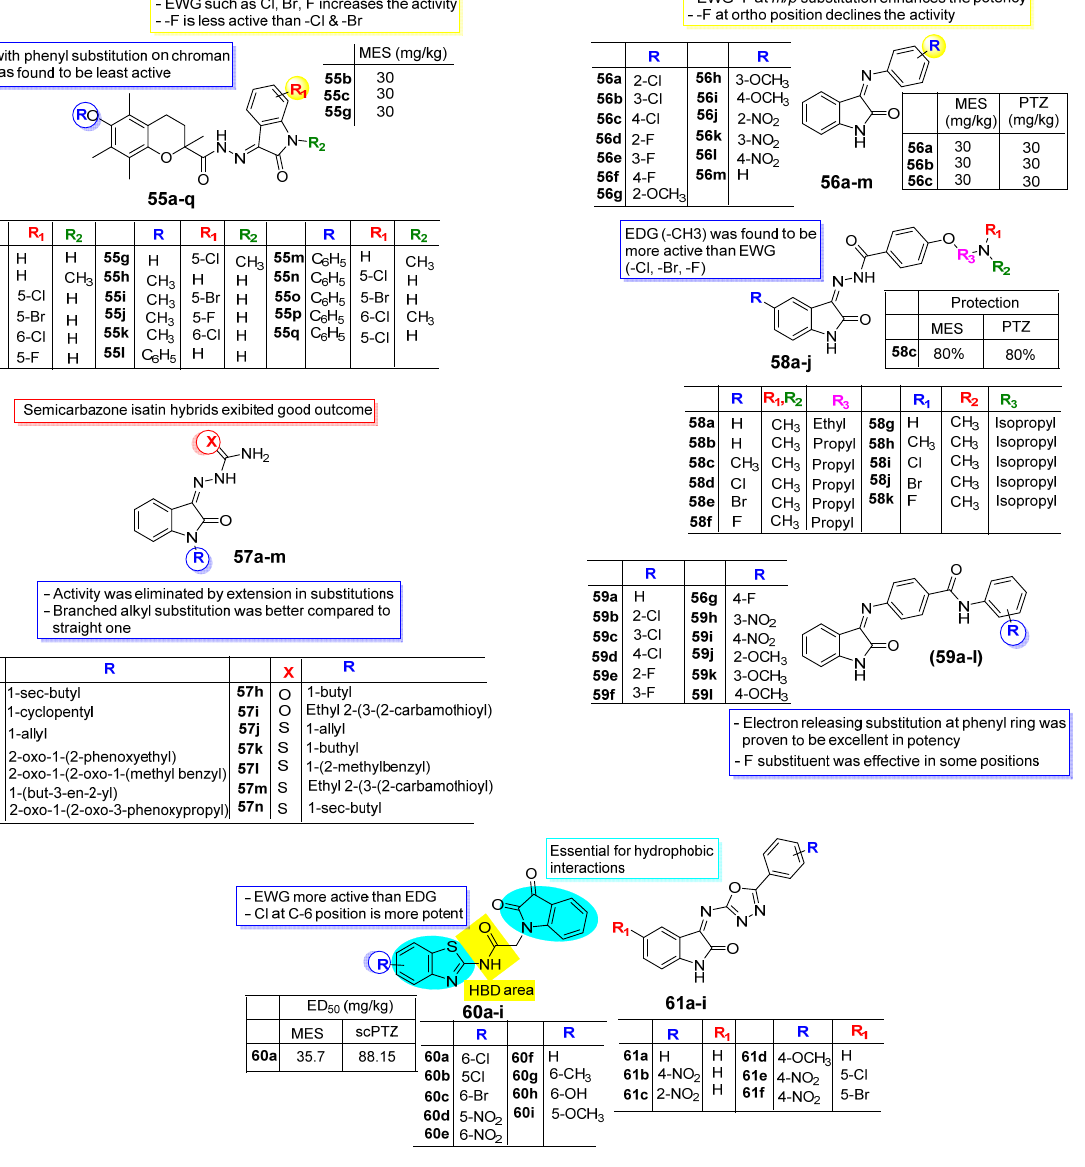
Figure 6. SAR features suggesting anticonvulsant potential of isatin derivatives. Rahmani-Khajouei et al. [78], in 2017, synthesized some isatin-based derivatives ( 56a – m , Figure 6) for their anticonvulsant potential using MES and PTZ, and a neurotox- icity study assessed this using a rotarod test. Among the newly prepared analogues, the majority of the compounds displayed noteworthy preventive outcomes at a 30 mg/kg dose in both MES and PTZ models with acceptable neurotoxicity. A SAR study revealed that the compound with electron-withdrawing species -F caused an increased in potential compared to -Cl. The position of the substitution of -F greatly influences the activity. F incorporated at meta and para positions displayed protection in both models, while -F in an ortho position decreased the potential. Chlorinated analogues 56a , 56b , and 56c exhib- ited prevention at a dose of 30 mg/Kg in both MES and PTZ. Analogues with nitro